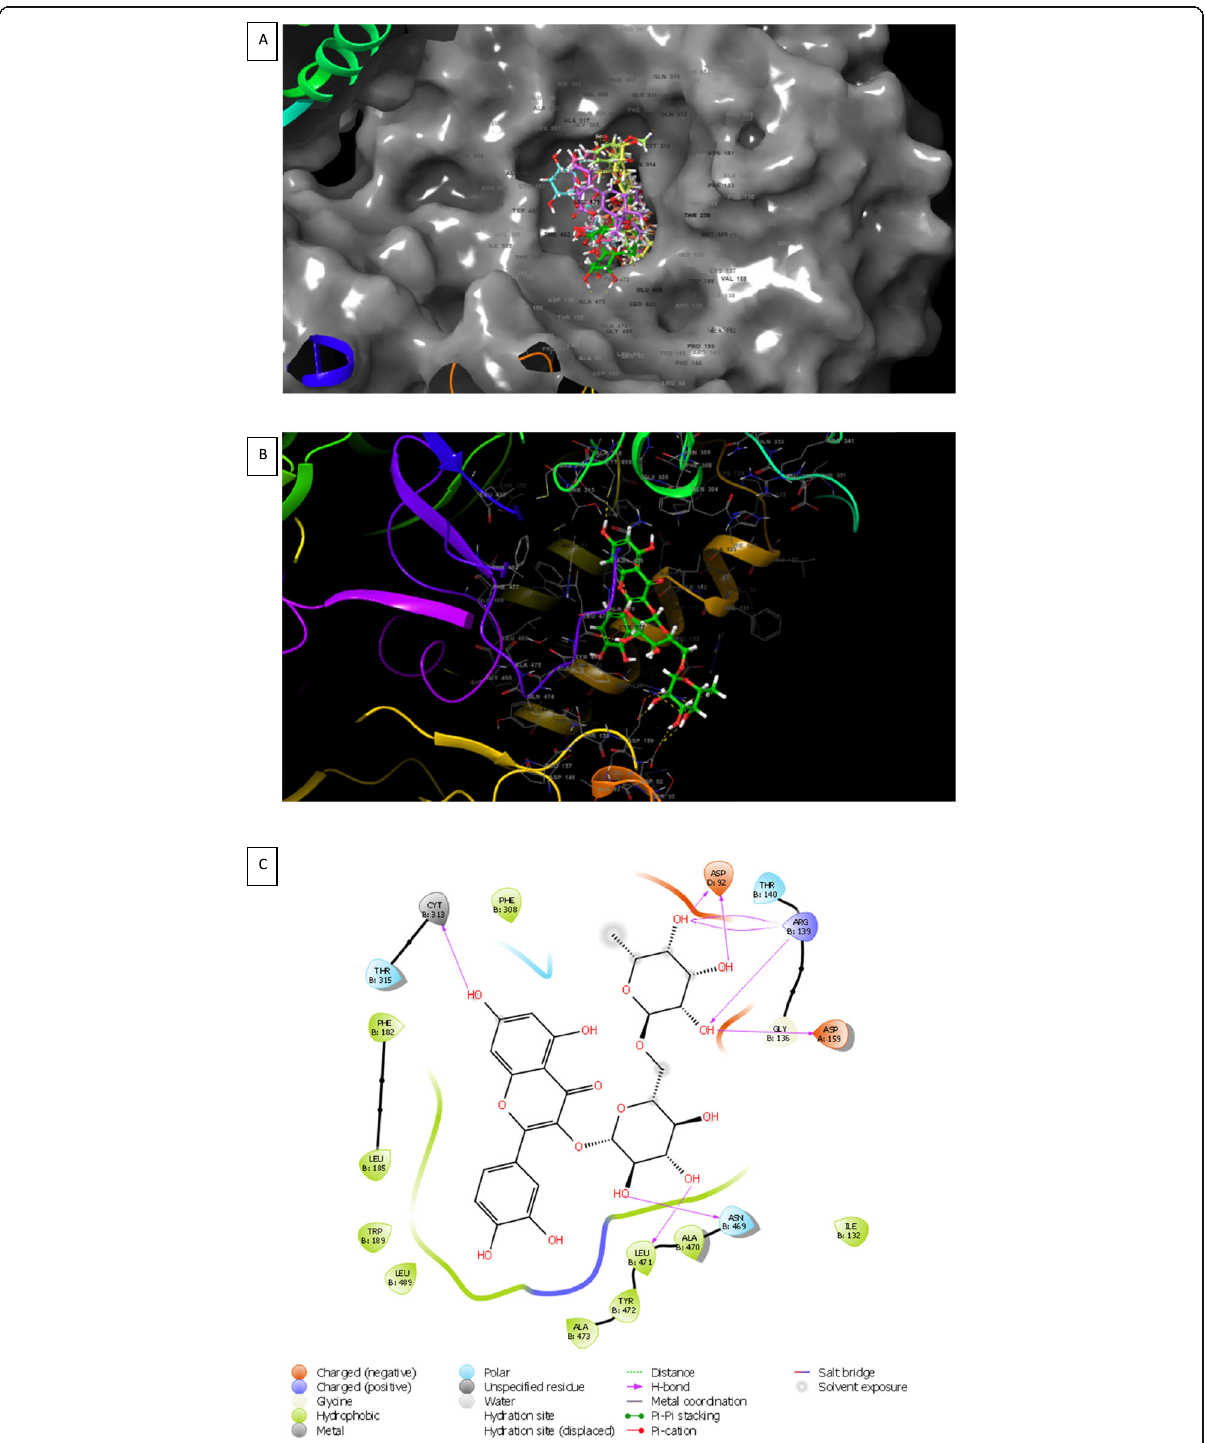
Fig. 3 a The probable binding mode of all ligands to ALDH1A3. b Interaction diagram of rutin ligand with ALDH1A3 protein: the yellow dotted lines in 3D figure indicates the hydrogen bond between the ligand and protein receptor. c Two dimensional interaction diagram indicates the rutin interaction with ALDH1A3, one hydrogen bond is between the ligand and amino acid 471 leucine, 469 aspargine, 92 aspartic acid, 159 aspartic acid, and 139 arginine residue in receptor of